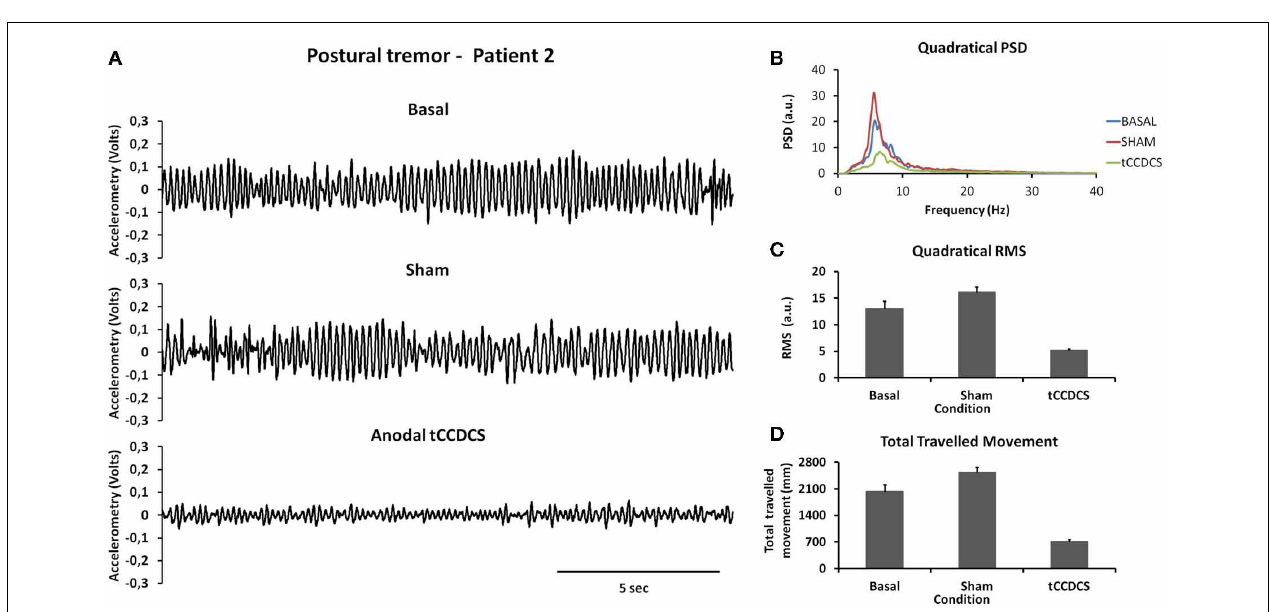
peak PSD following tCCDCS (blue line: baseline; red line: post-sham; green line: post-tCCDCS). Quadratical PSD is expressed in arbitrary units (a.u.). (C) Quadratical RMS (expressed in a.u.) of all epochs of postural tremor. (D) Total traveled movement (expressed in mm). Values in (C) and (D) are mean ( ± SD ) of all epochs.